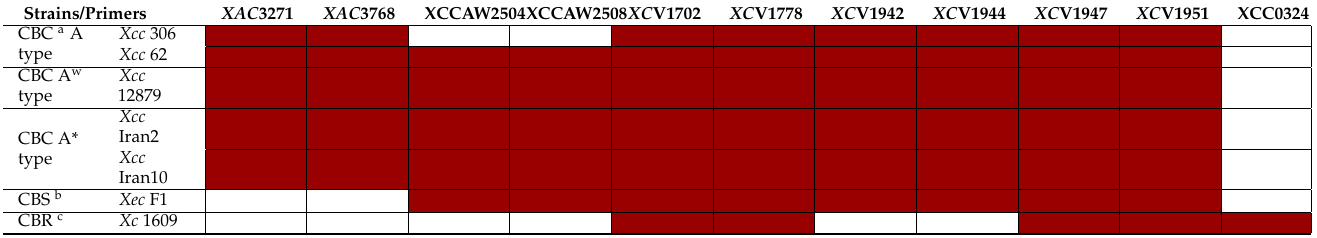
MCP content (Figure 2, Table 5).